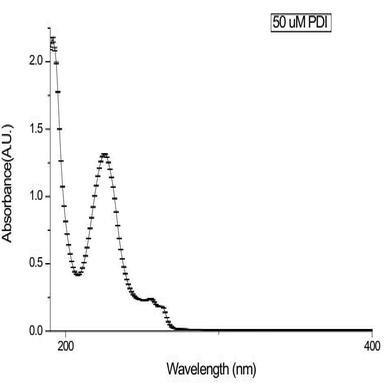
50 µM DMPI at 298 K in water (Plot with standard deviation data).